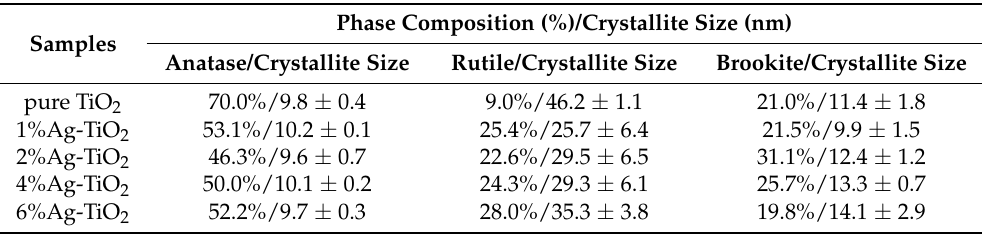
Table 1. Phase composition and average crystallite size of pure TiO 2 and Ag-TiO 2. Phase Composition (%)/Crystallite Size (nm) Samples Anatase/Crystallite Size